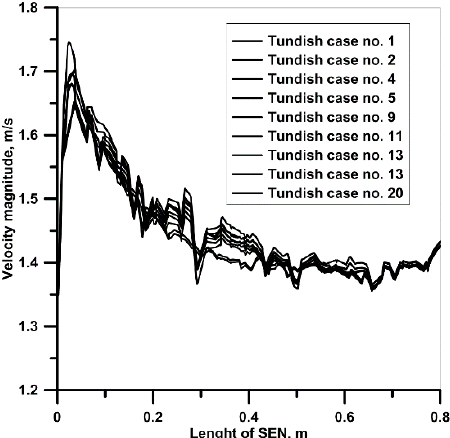
Figure 9. Liquid steel velocity magnitude in the submerged entry nozzle for selected hydrodynamic conditions